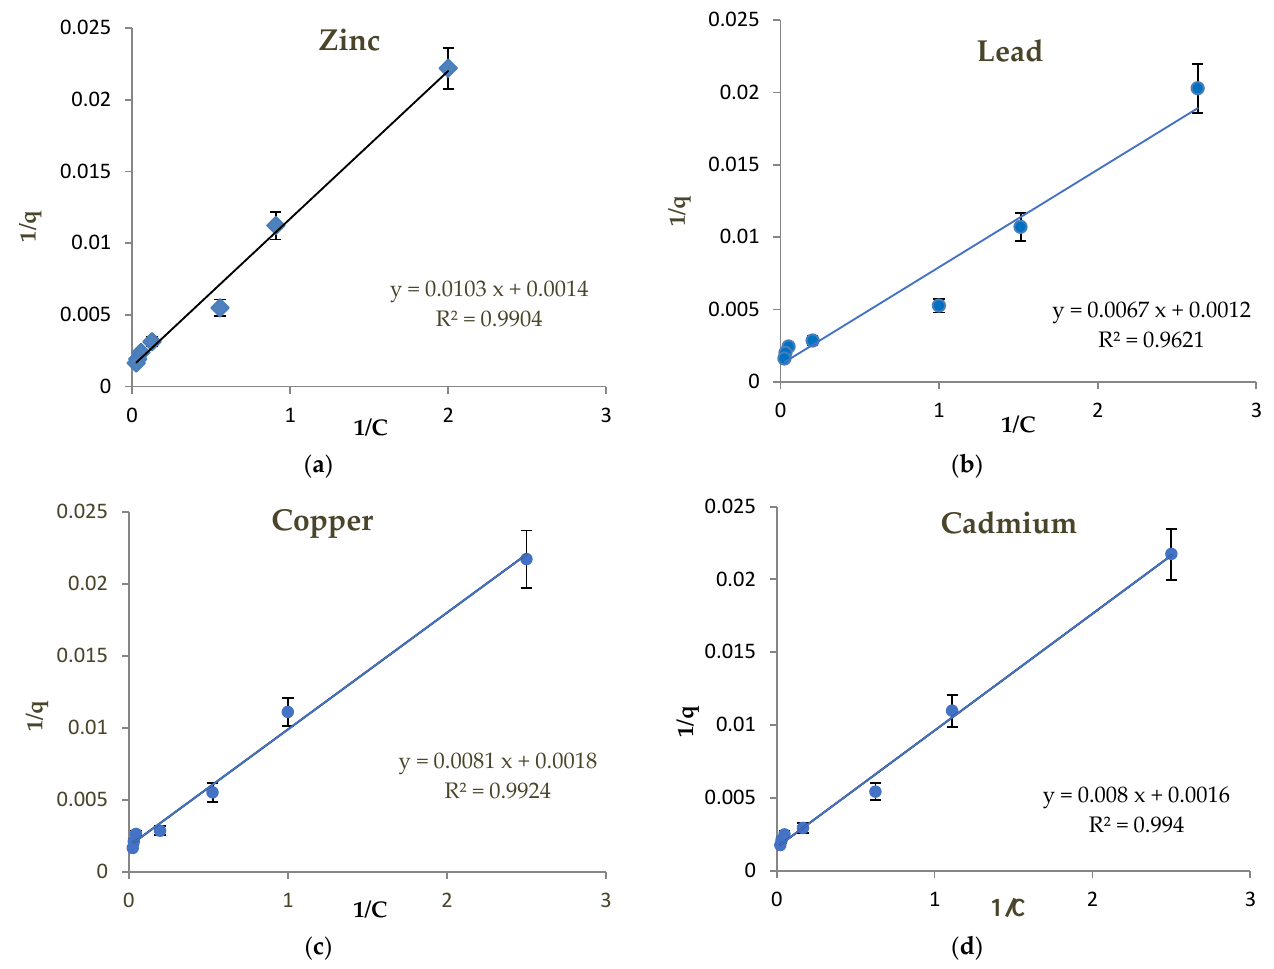
Figure 3. The Langmuir isotherm adsorption of Zn, Pb, Cu, and Cd ( a – d ) in the alkaline soil sample.